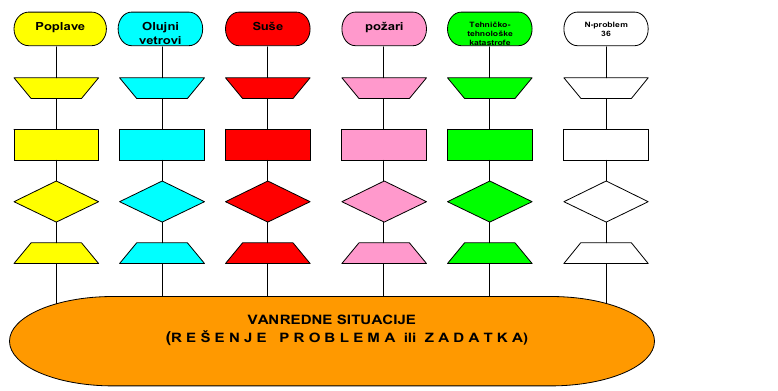
Slika 2 – Problemska situacija – heuristi č ki algoritam Figure 2 – Problem situation-heuristic